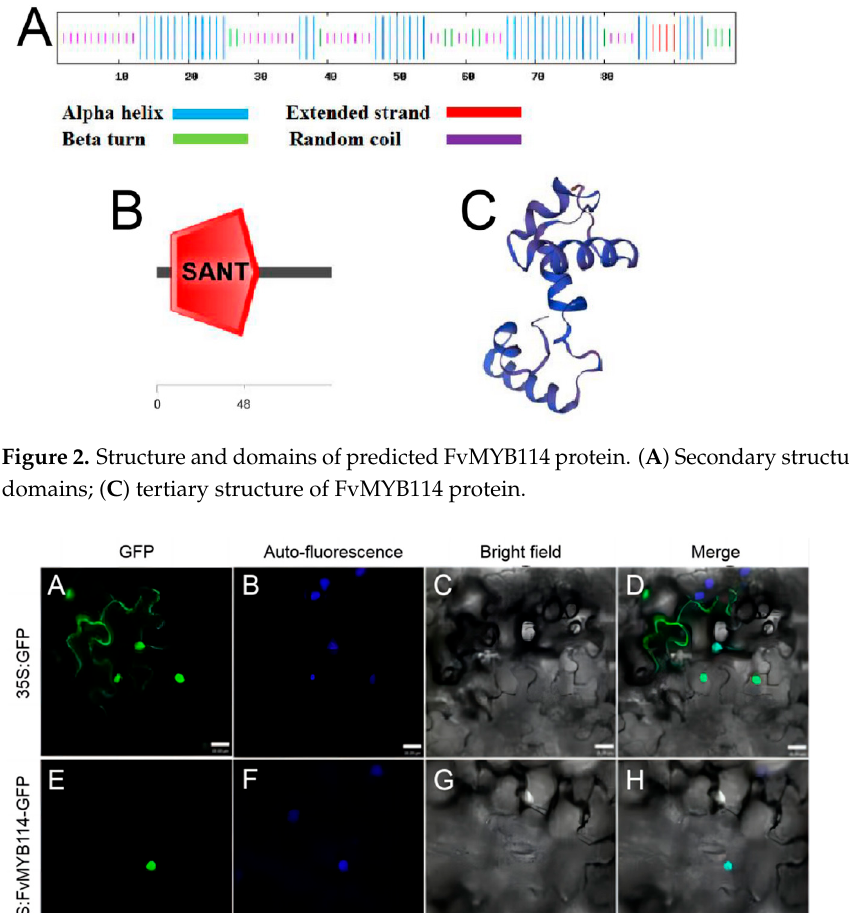
Figure 2. Structure and domains of predicted FvMYB114 protein. ( A ) Secondary structure; ( B ) pro- tein domains; ( C ) tertiary structure of FvMYB114 protein.